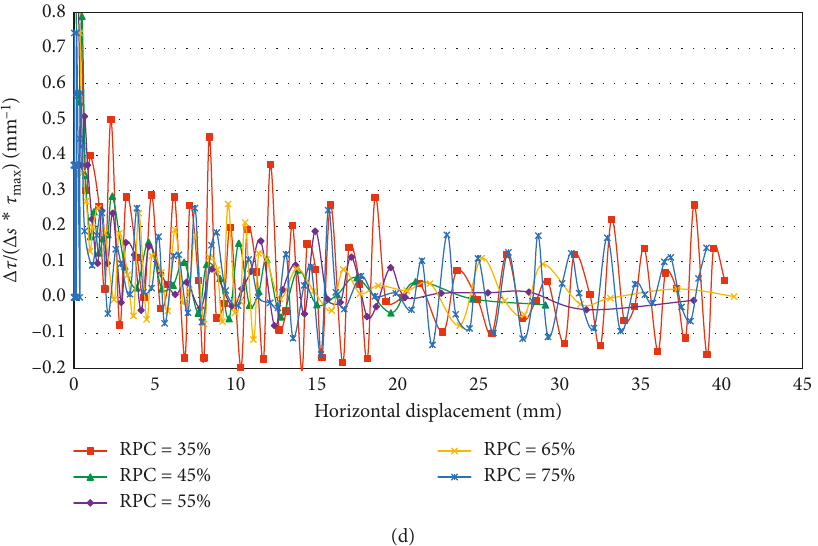
Figure 7: ∆ τ / ∆ s ∗ ( τ max − s ) curves of different rock particle contents under the same normal stress: (a) normal stress σ n (b) normal stress σ n � 283.1 kPa; (c) normal stress σ n � 424.6kPa; (d) normal stress σ n �